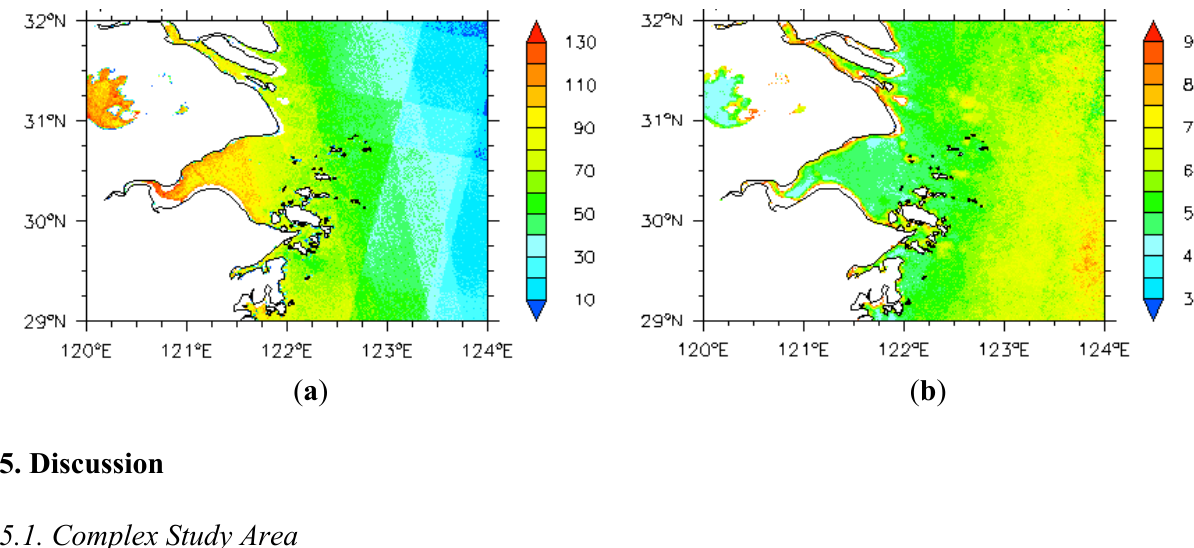
Figure 9. Maps showing: ( a ) the number of overlapping satellite scenes; and ( b ) the 10-m mean wind speed for the Hangzhou Bay, the spatial resolution of maps are 1 km by 1